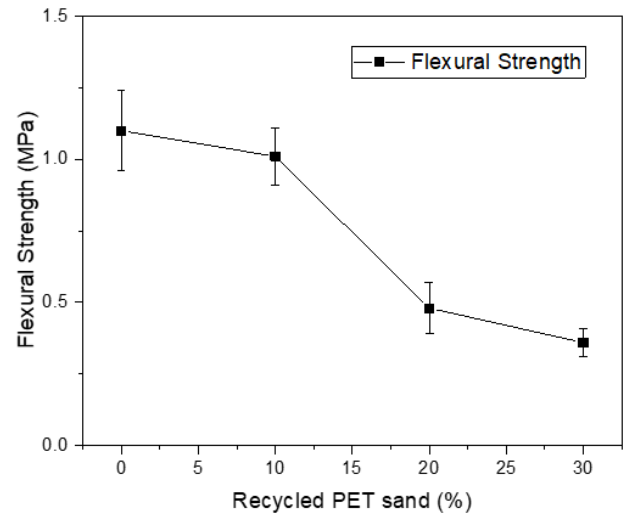
Figure 5. Flexural strength results.